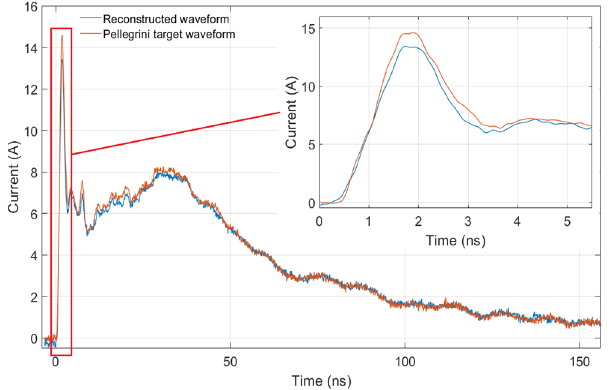
Figure 12. Comparison of the reconstructed waveform applying the proposed methodology with the Pellegrini target (reference) waveform for a +4 kV pulse of the Schaffner NSG 438 ESD generator including a zoomed view of the initial peak.